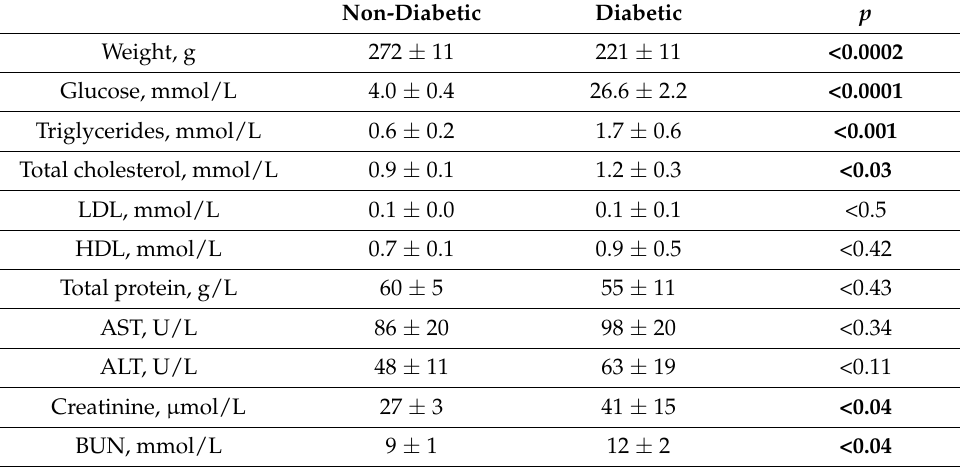
Table 2. Body weight and serum biomarkers in non-diabetic and diabetic